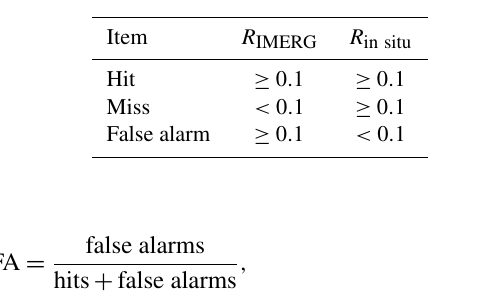
Table 1. Definition of thresholds for “hit”, “miss”, and “false alarm” (mm per